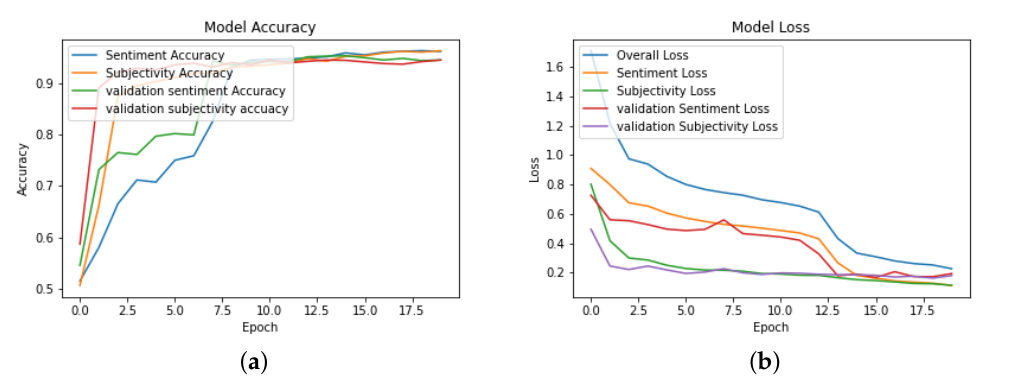
Figure 2. MTL based on BERT embedding. ( a ) Accuracy graph. ( b ) Loss